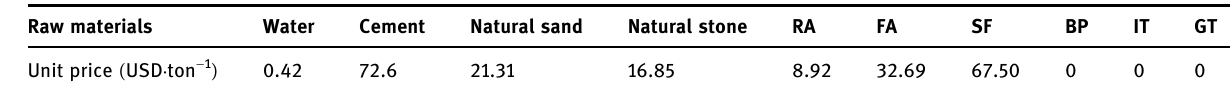
Table 7: Unit price of raw materials Raw